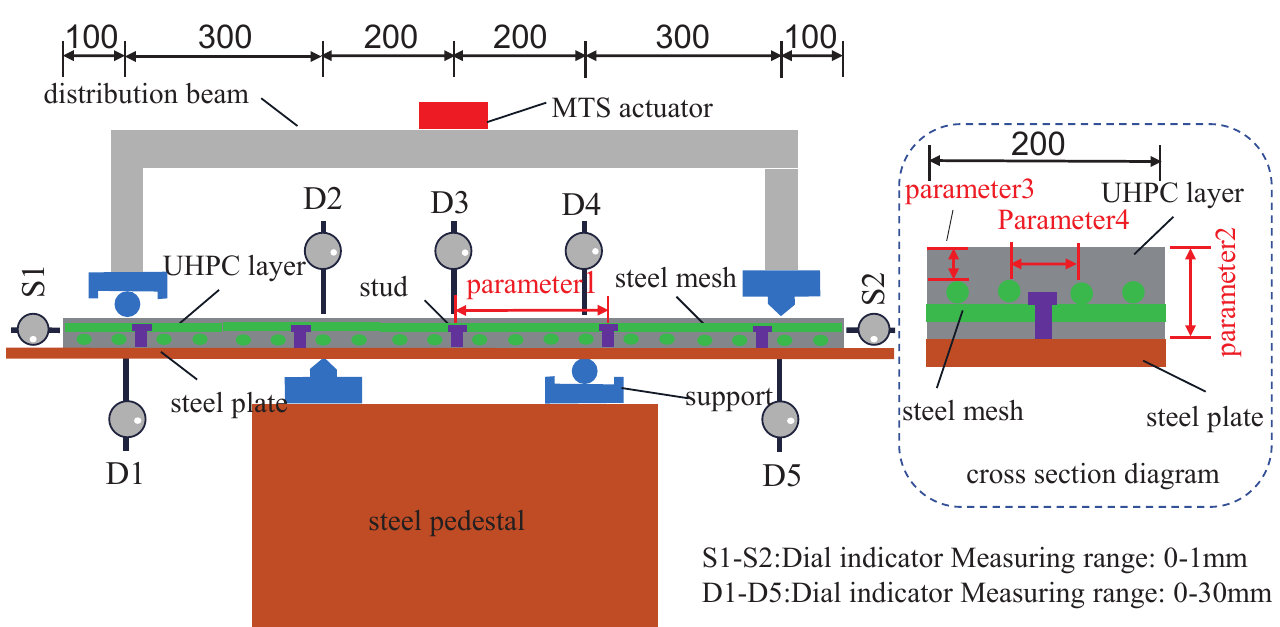
S1-S2:Dial indicator Measuring range: 0-1mm D1-D5:Dial indicator Measuring range: 0-30mm